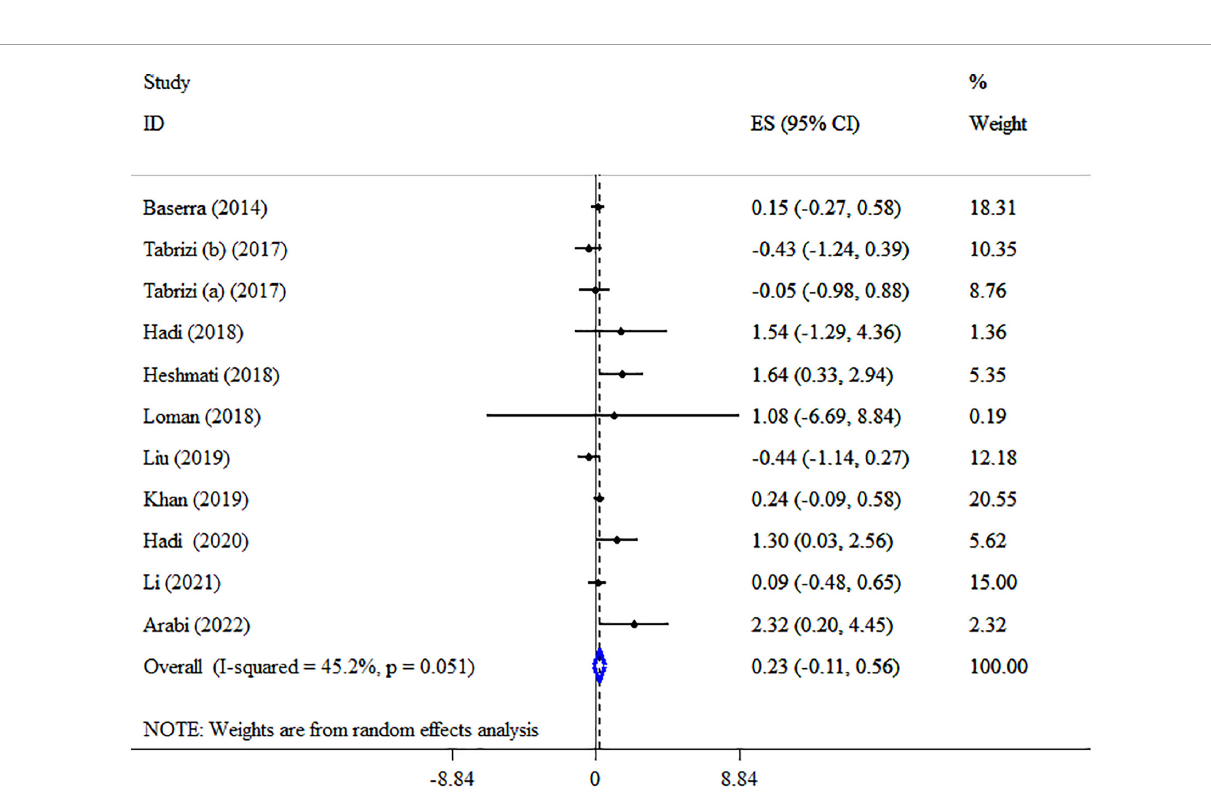
Frontiers in Nutrition